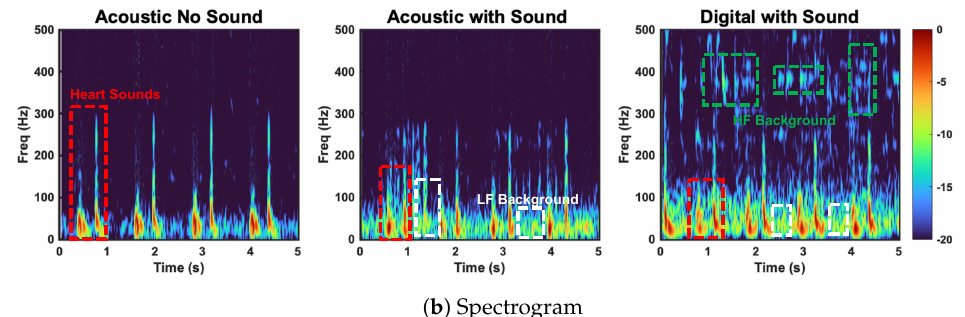
Figure 16. Comparison of the acoustic stethoscope without background sound, the acoustic stethoscope with background sound, and the digital stethoscope with background sound. Heart sound and high − and low − frequency background sounds are circled. Low − frequency background sounds are captured by the acoustic and digital stethoscope. HF background sounds are captured by the digital